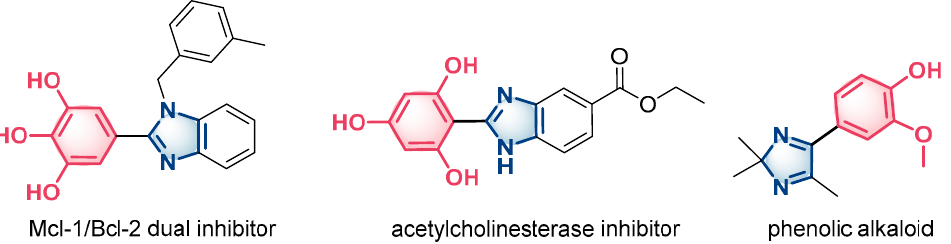
Figure 2. Examples of azaheterocyclic phenolic compounds in the design of candidates for active pharmaceutical ingredients (APIs).